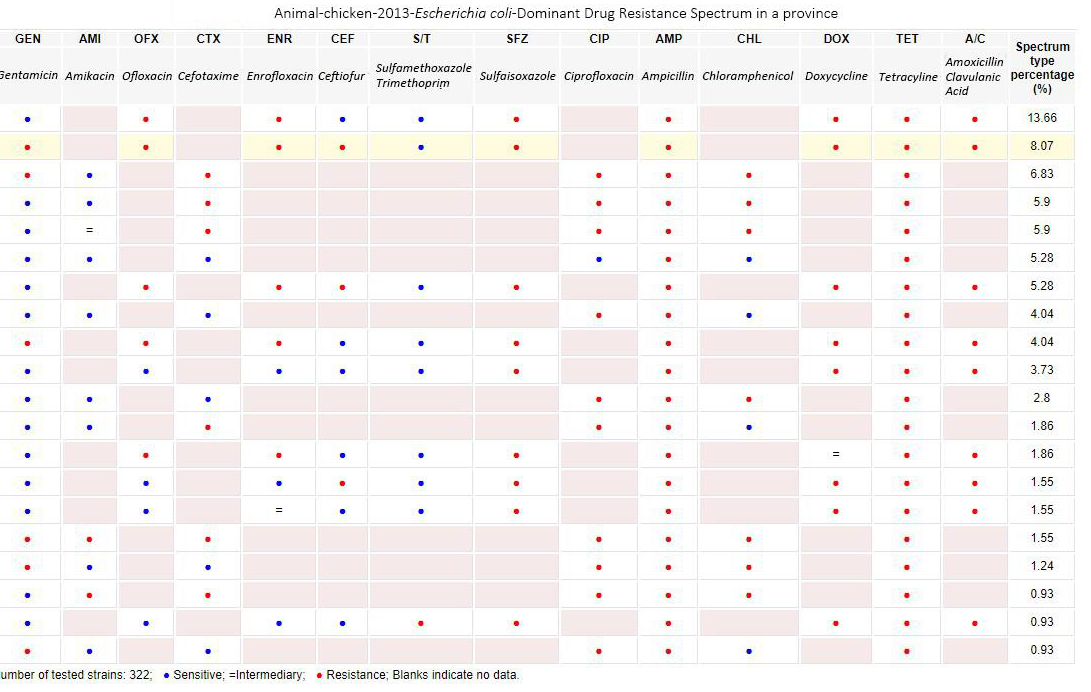
Figure 6. Drug resistance spectrum query (sample data).